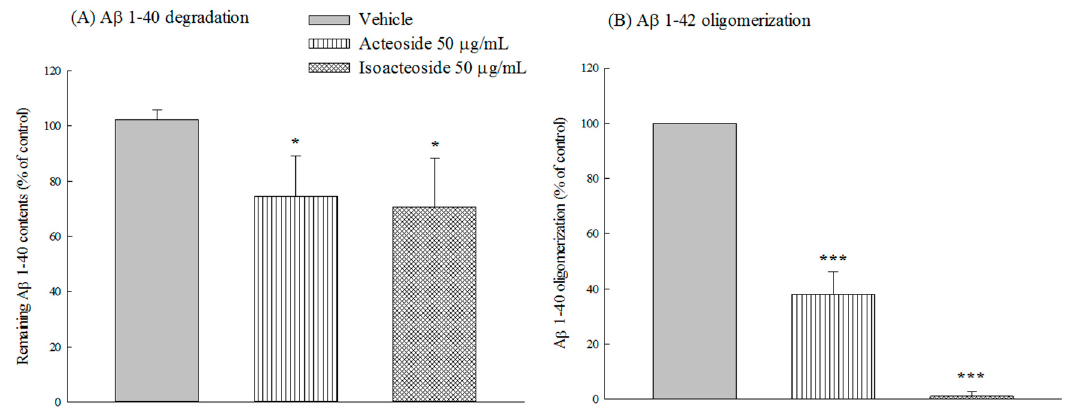
Figure 8. Effects of acteoside or isoacteoside (50 μ g/mL) on: ( A ) A β 1-40 degradation; and ( B ) A β 1-42 oligomerization in vitro. Acteoside or isoacteoside was co-cultured with A β 1-40 or A β 1-42. Columns indicate mean ± SD ( n = 4). * p < 0.05, *** p < 0.001 compared with vehicle group.